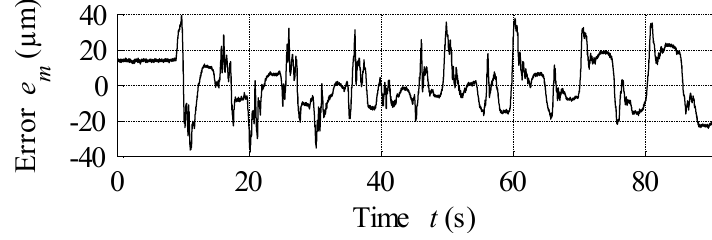
Figure 13. Comparison of hysteresis curves obtained via measurement and simulation for damped sine input (black curve is measured, red curve is output of simulation model).